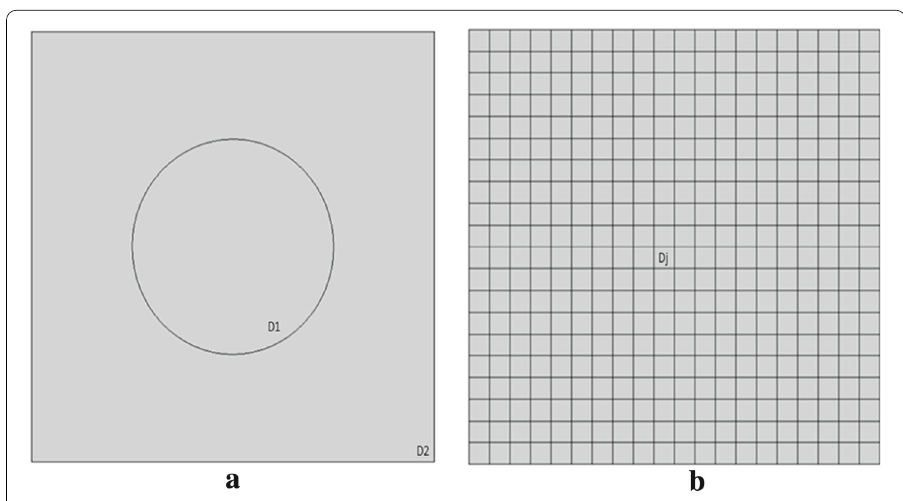
Fig. 2 Geometry for the identification: a two identification domains respecting the material heterogeneity and b 400 identification domains that do not respect the material